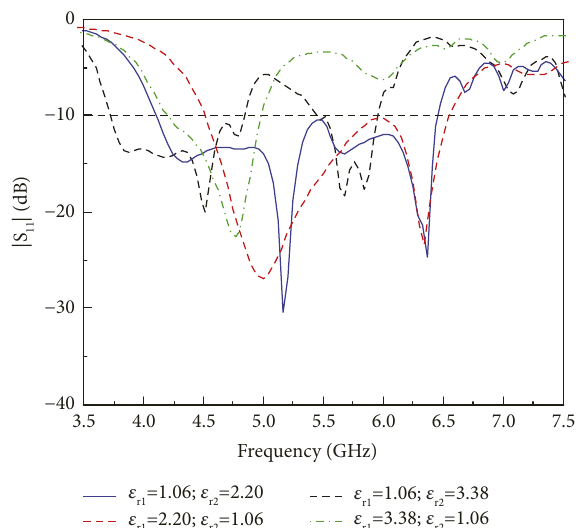
Figure 7: Effects of different dielectric constants for the lower and upper substrates on the reflection coefficient of the antenna.